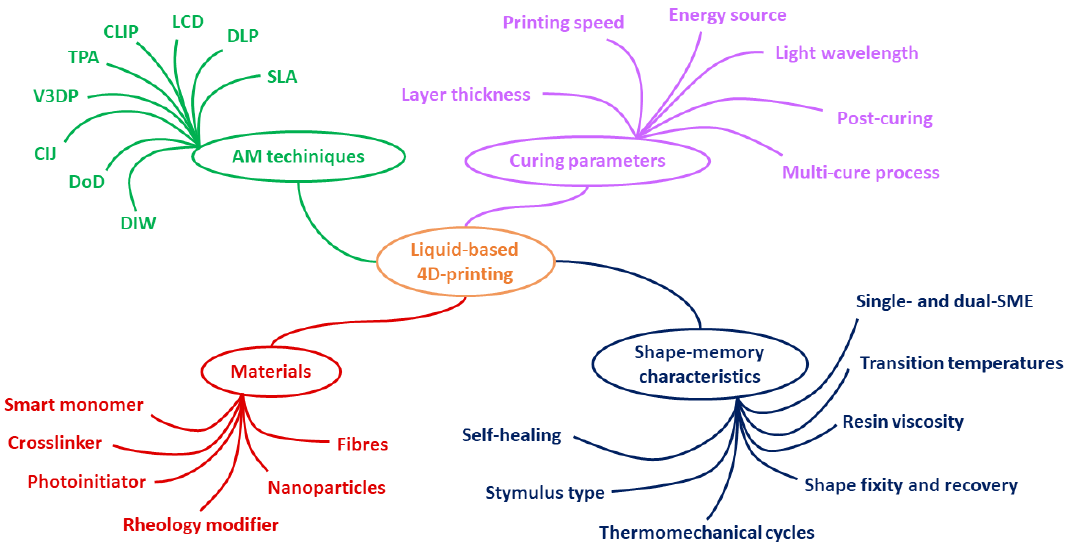
Figure 3. Liquid-based 3D printing of shape memory polymers.